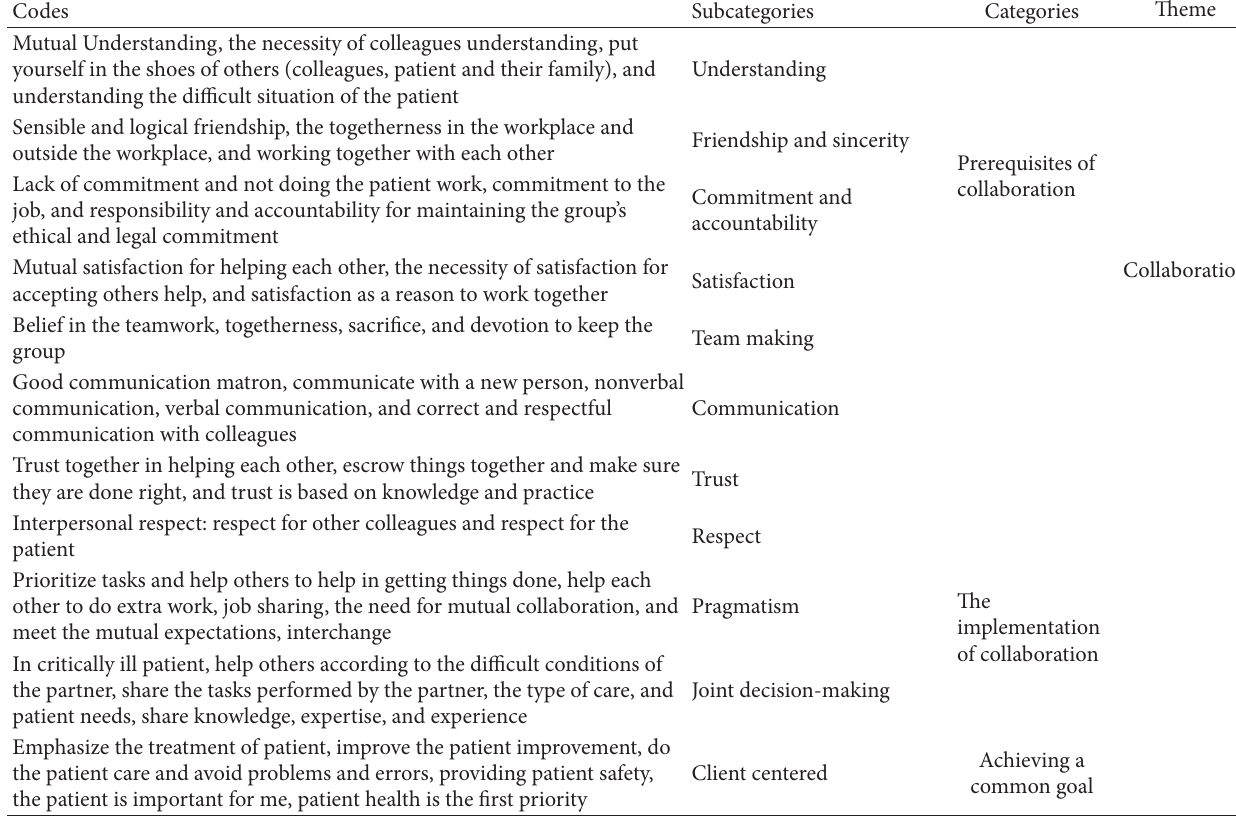
Table 1: The process of obtaining theme from categories, subcategories, and